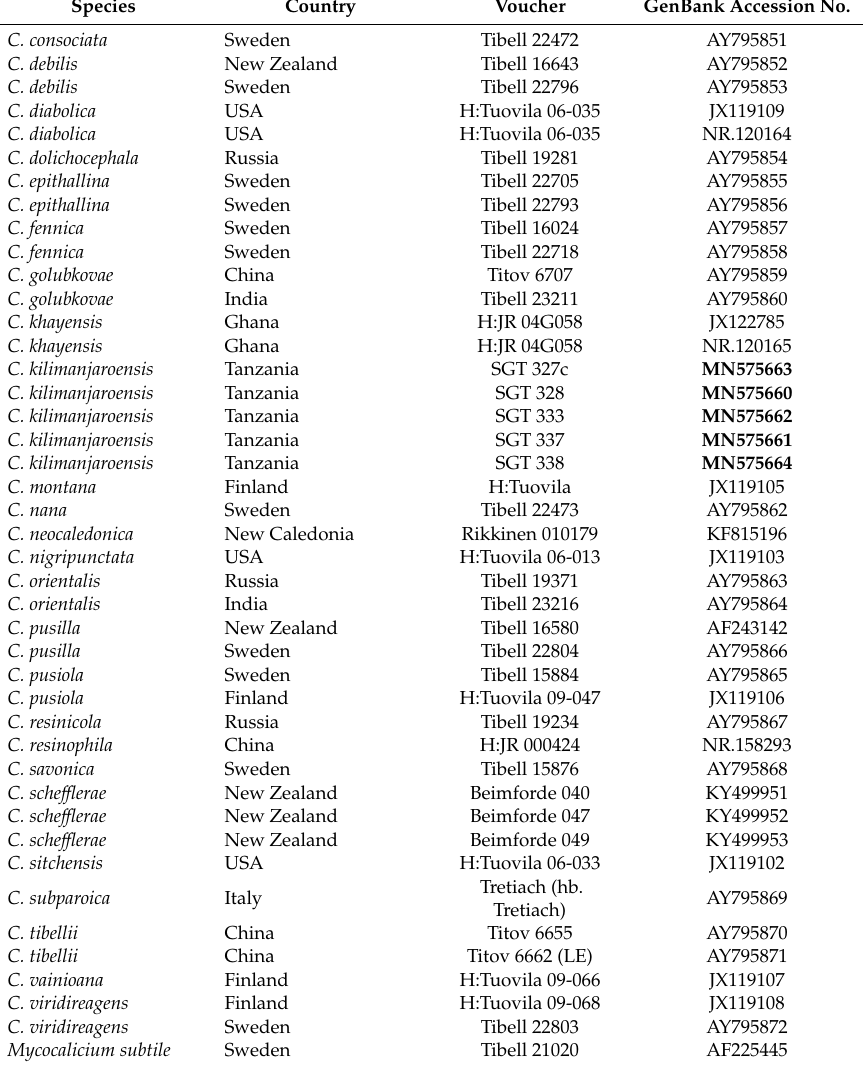
Table 1. Specimens used in an Internal transcribed spacer (ITS)-based phylogenetic analysis of Chaenothecopsis species together with their GenBank accession numbers. New sequences are in